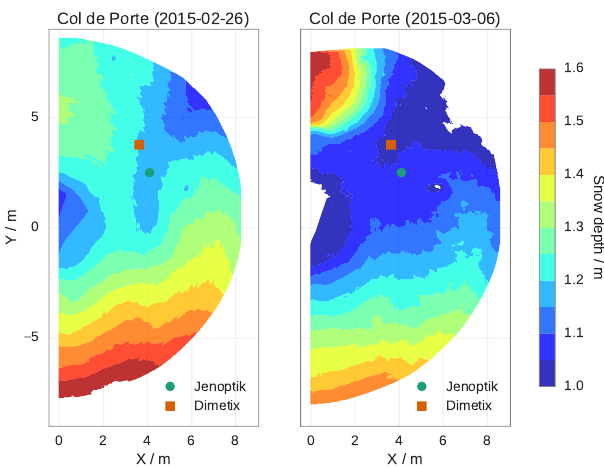
Figure 8. Two snow depth maps acquired at Col de Porte 26 Febru- ary 2015 when the snow depth reaches its maximum and 6 March 2015 after a wind slab appeared in the northern corner ( x = 0; y = 6m). North is approximately in the y -axis direction. The square and round symbols represent the footprint of the SPICE sensors at the beginning of the